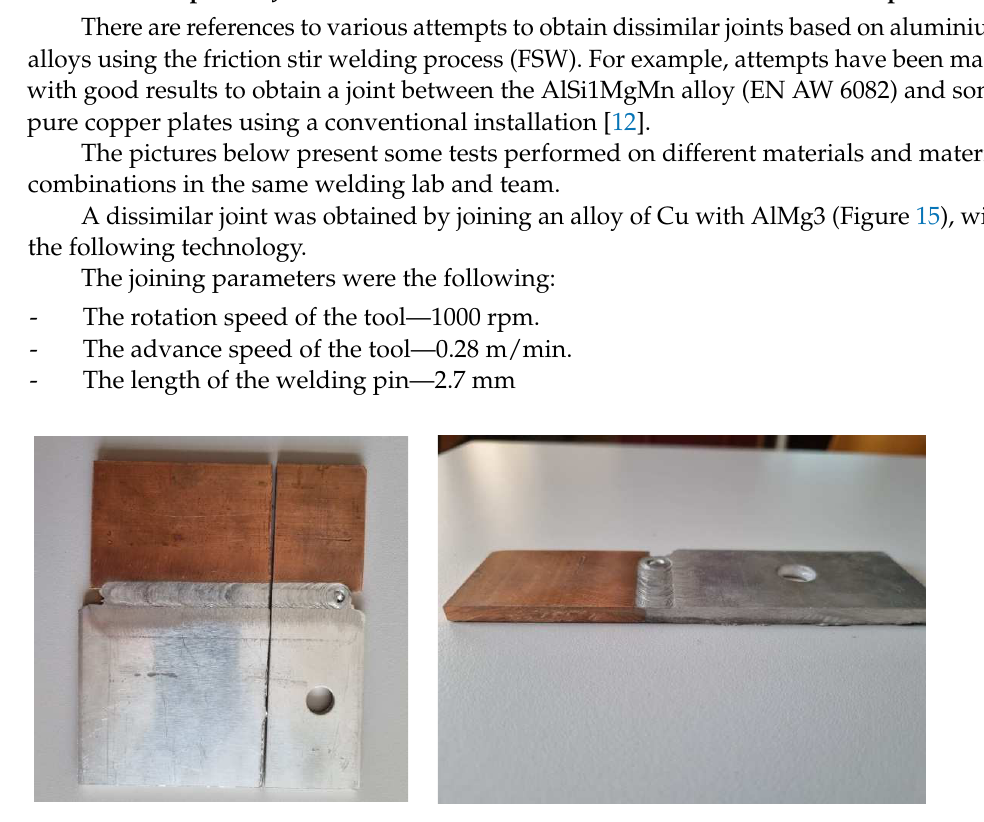
Figure 15. A joint of the AlMg3 + Cu alloy.